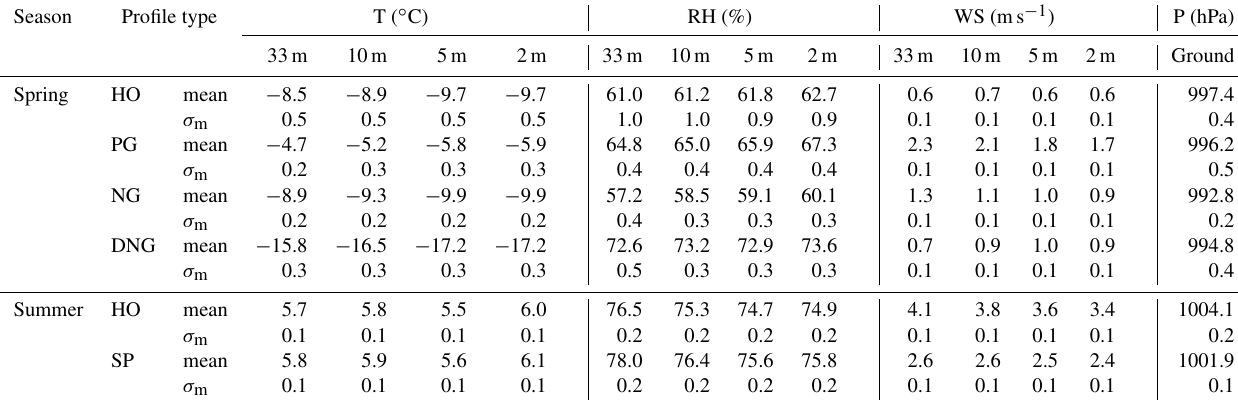
Table 2. Meteorological parameters (temperature, relative humidity, wind speed, pressure) measured at the CCT at different levels (33, 10, 5 and 2m) and averaged (timely coincident) for each profile class.